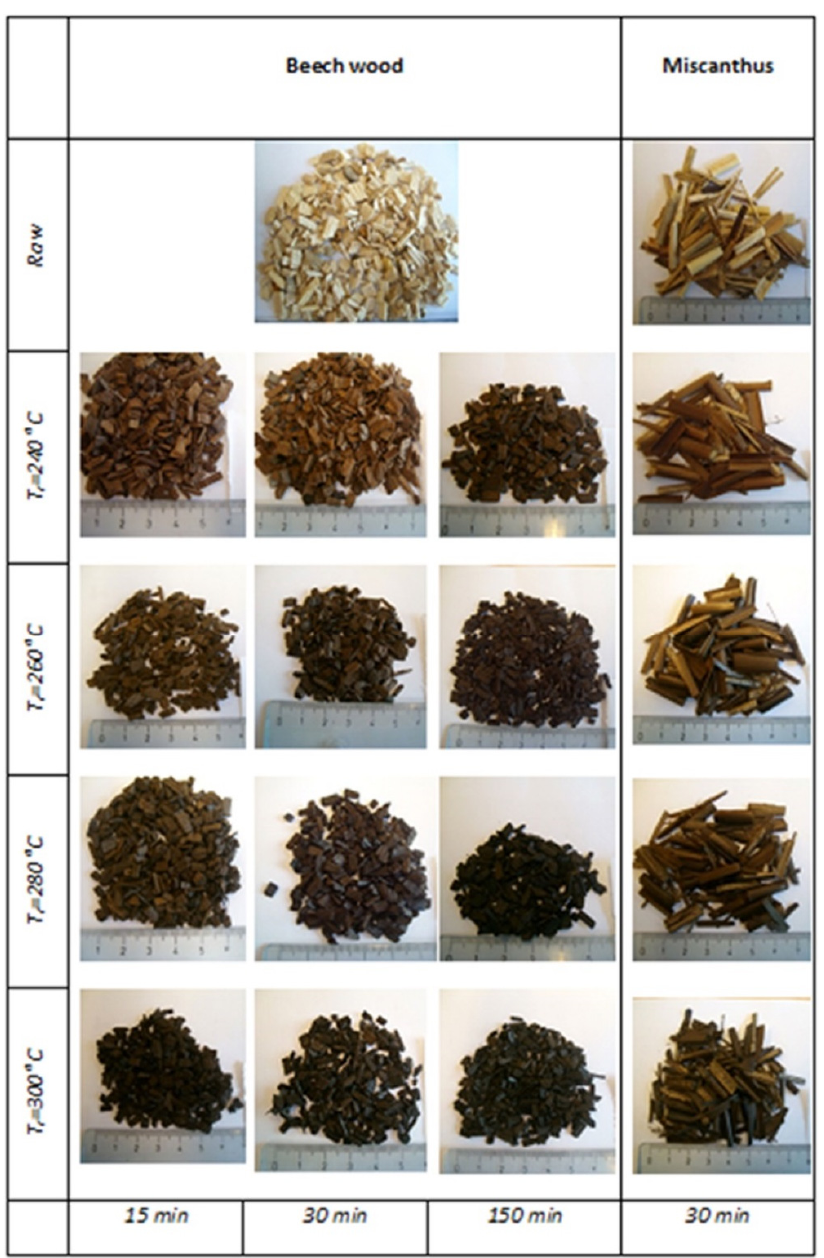
Figure 3. Photograph of beech wood and miscanthus particles and their torrefied products at different torrefaction temperatures and residence